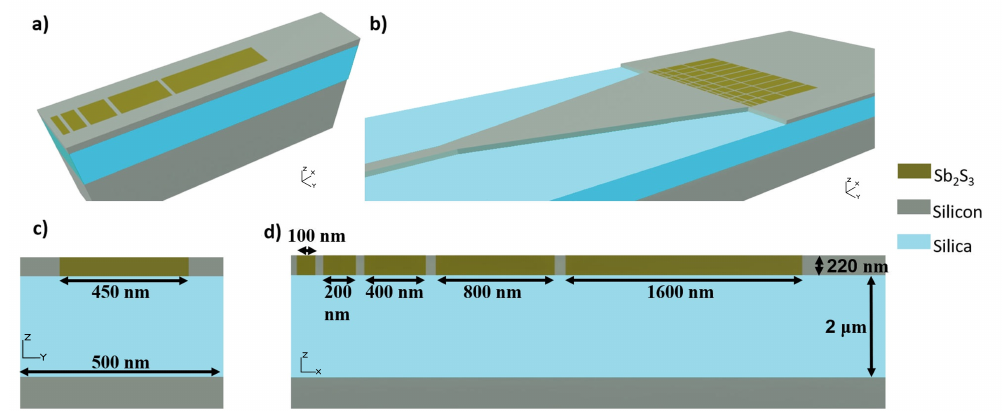
Figure 1. The schematic of the ( a ) single array of Sb 2 S 3 cells of increasing length, ( b ) a photonic crystal composed of a number of arrays of Sb 2 S 3 coupled with an incoming waveguide through a taper’s, ( c ) cross-sectional view of a unit cell and ( d ) a cross-sectional view of the array of Sb 2 S 3 along with the measurements of each unit along the direction of